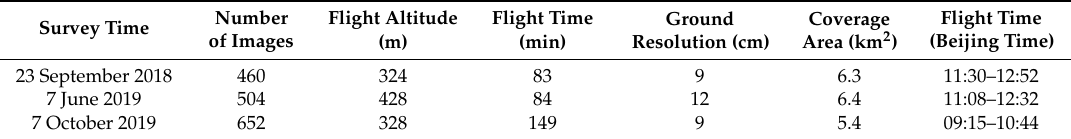
Table 1. UAV photogrammetric flights used for acquisition of glacier